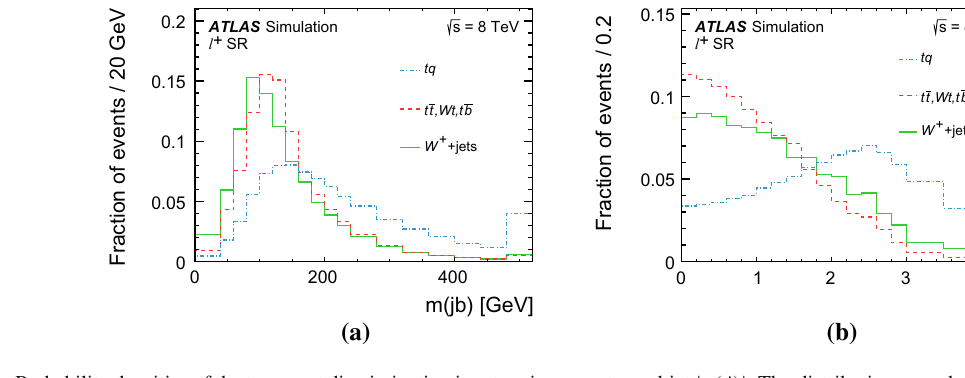
and their ratio. The uncertainties are split into the following